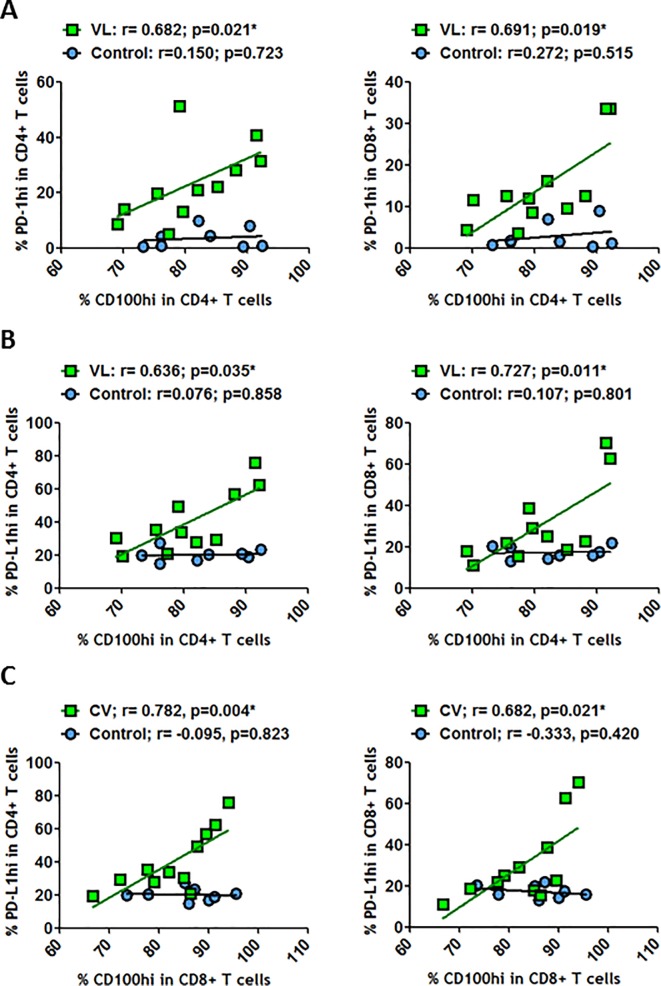
Correlations between CD100hi and PD-1hi or PD-L1hi on T or B cells.(A) Correlations between frequency of CD100hi on CD4+ T cells and frequencies of PD-1hi on CD4+ T cells and on CD8+ T cells. (B) Correlations between frequencies of CD100hi on CD4+ T cells and frequencies of PD-L1hi on CD4+ T cells and on CD8+ T cells. (C) Correlations between frequencies of CD100hi on CD8+ T cells and frequencies of PD-L1hi on CD4+ T cells and on CD8+ T cells. All these correlations were determined in healthy individuals and in VL-HIV-1+ individuals. Correlations were determined by Spearman’s rank correlation. * = p<0.05 when comparing conditions. Each symbol corresponds to an individual.